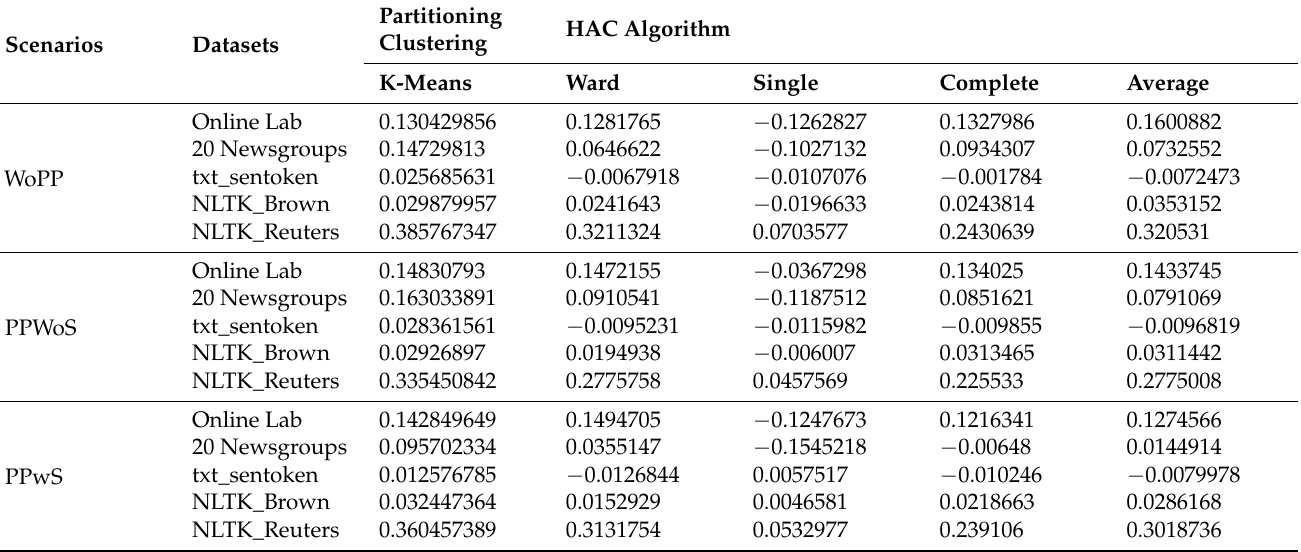
Table 1. Similarity Ratio for the optimal cluster number = 13 with different scenarios.